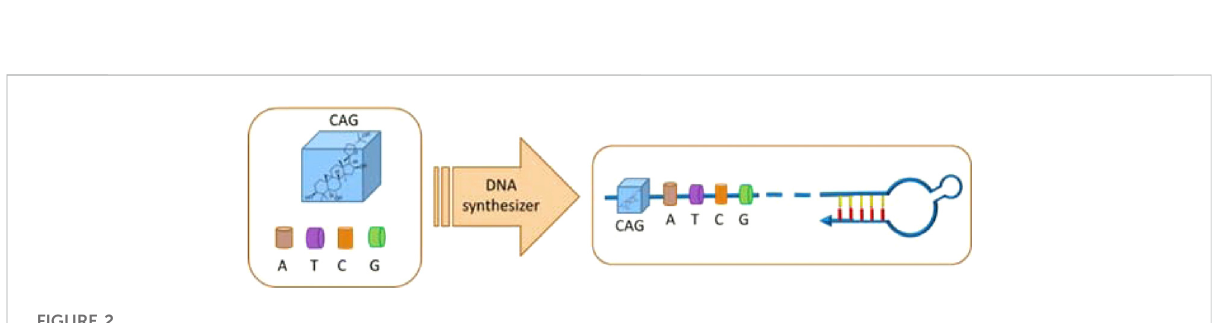
FIGURE 2 SchematicillustrationforthesynthesisprocessofON-CAGconjugates.CAGphosphoramiditewasligatedtotheoligonucleicacidsequenceby a DNA synthesizer to form ON-CAG